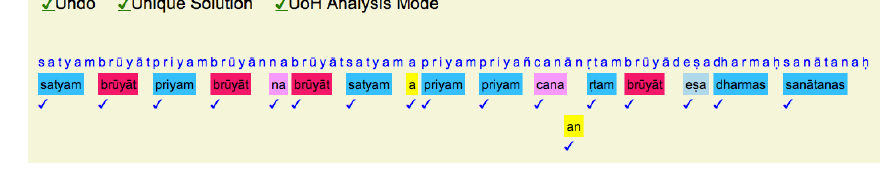
Figure 3: Aligned segments after 4 clicks